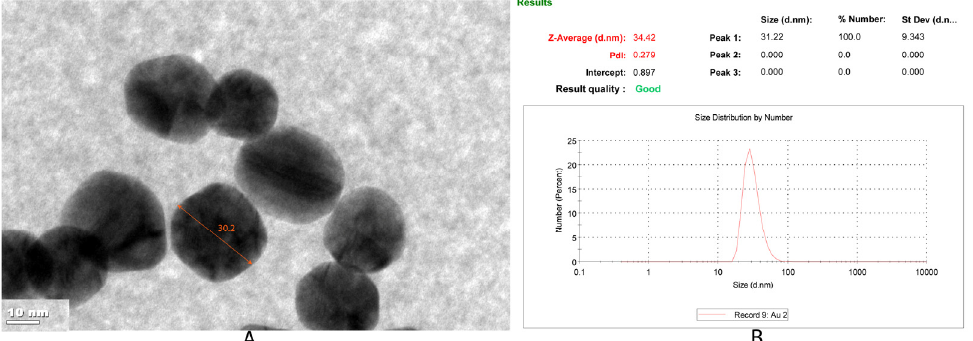
Figure 1. ( A )TEM image and ( B ) DLS analysis of